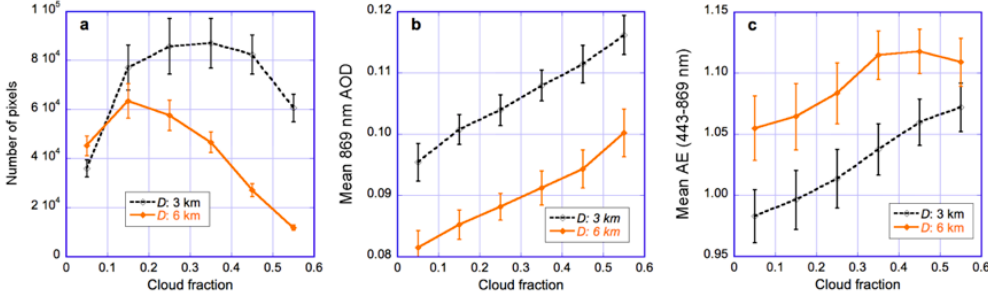
Figure 11. Impact of cloud fraction at two distances from clouds (D = 3 km and D = 6 km). ( a ) Number of pixels; ( b ) aerosol optical depth; ( c ) Angstrom exponent. The data is plotted for the region and time period examined in Figures 2, 3, 5 and 10. The error bars indicate the uncertainties due to interannual variability, estimated from the spread of results for individual years. Similar to Figure 10, all QA flags are used to screen the data except for the STRL and SSTW flags. The figure is based on Figure 7 of [50].